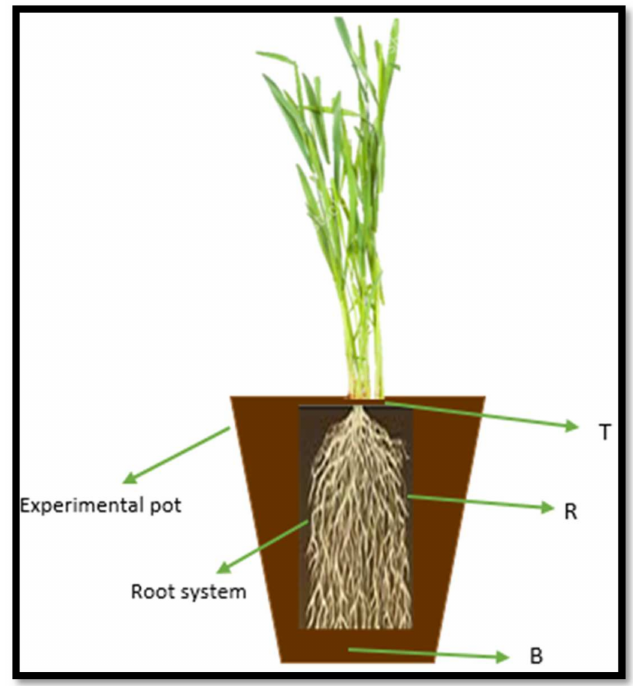
Figure 1. Soil sampling locations (T: top soil sample, B: bottom soil sample, R: rhizosphere soil